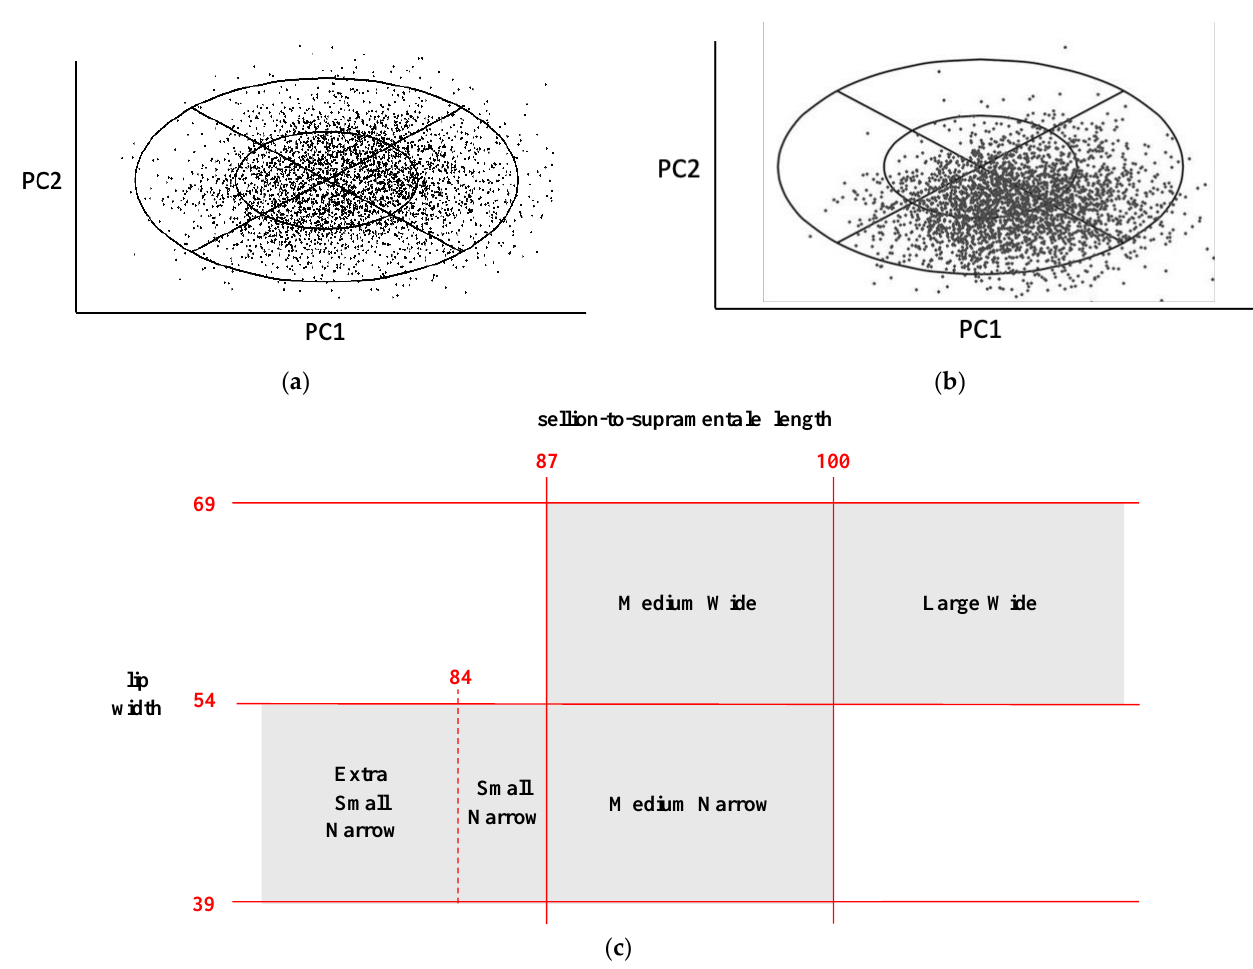
Figure 1. Sizing system for facial masks (illustrated). ( a ) Sizing system of industrial masks for US workforces generated based on the principal component analysis on facial anthropometric measurements [7] ; ( b ) Inappropriateness of the sizing system for US workforces to Chinese workforces [9] ; ( c ) Sizing system of MBU-20/P pilot oxygen mask.